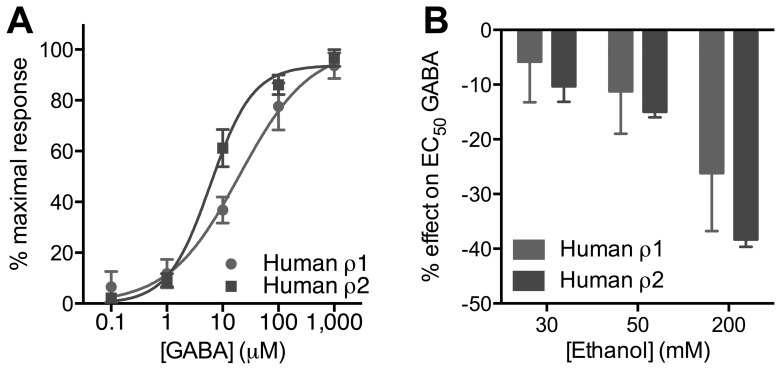
GABA sensitivity and ethanol modulation of currents produced by human ρ1 or ρ2 recombinant receptors in oocytes.A. GABA concentration-response curve for ρ1 (n = 5) and ρ2 (n = 6) GABAA receptors. B. Ethanol modulation of EC50 GABA-mediated currents for ρ1 (n = 4–5) and ρ2 (n = 3–9) GABAA receptors (no significant difference, two-way ANOVA).